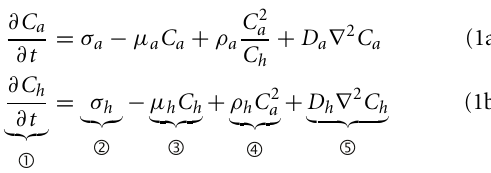
into osteoblasts ( ƒ ). In an extracellular process, the activator simultaneously enhances itself ( „ ) and the other key molecule (inhibitor) ( … ), while the inhibitor inhibits the activator ( † ).These two proteins eventually establish a regulatory loop and diffuse in space with different speed ( ‡ ) to form an inhomogeneous spatial pattern of concentration.